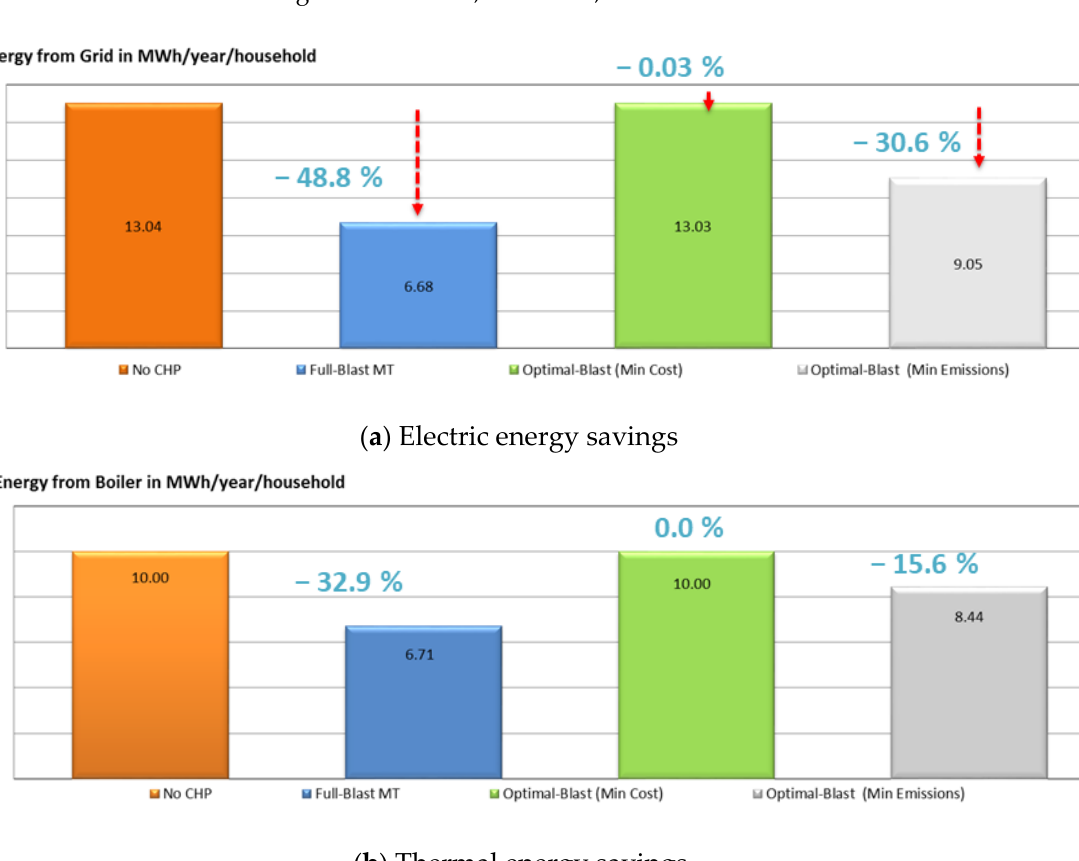
Figure 15. Duration curve when minimizing emissions over one year. Table 2. Utilization rates and operation times for minimizing emissions.